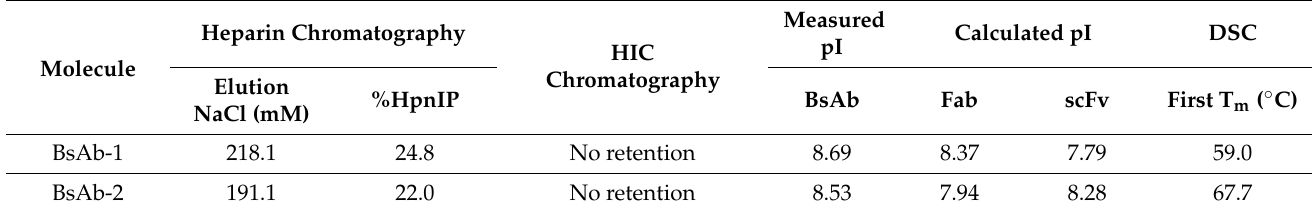
Table 1. Physiochemical Properties of the